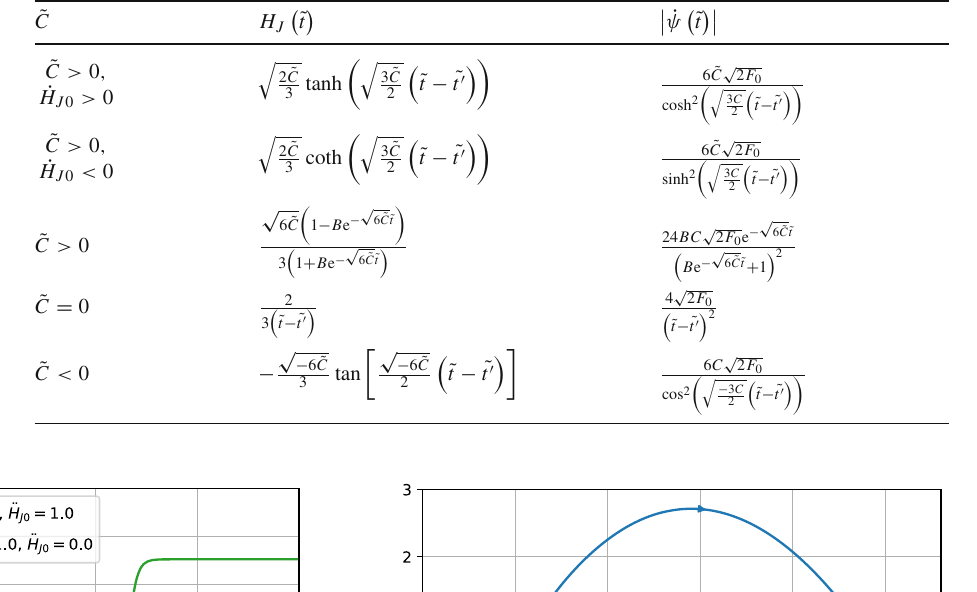
Table 1 List of the R 2 gravity exact solutions